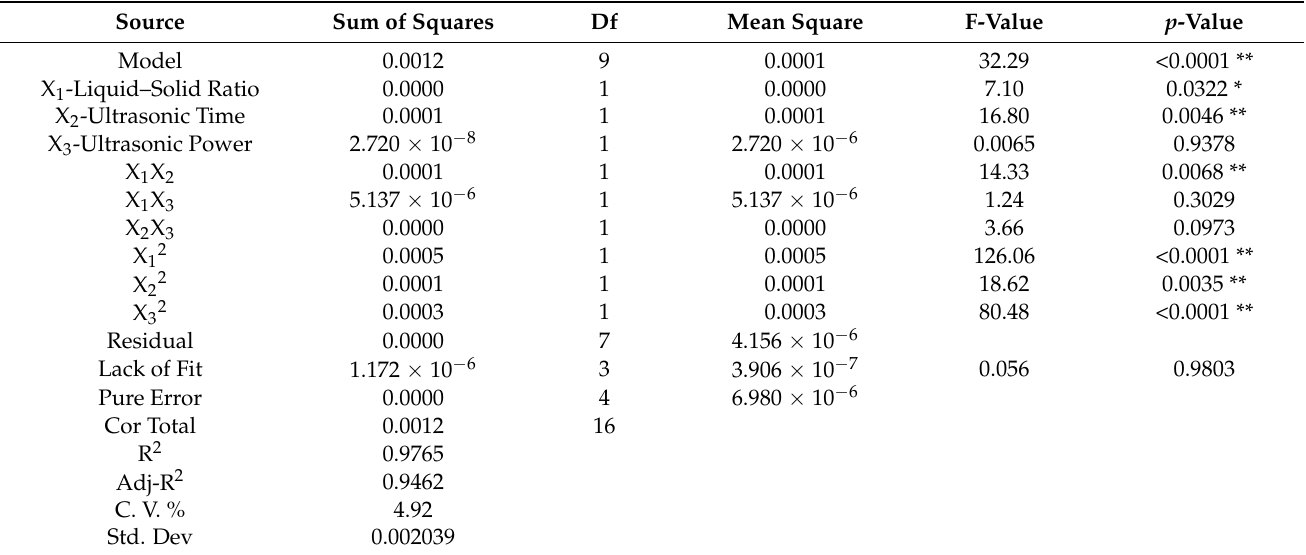
Table 3. Analysis of variance (ANOVA) results for